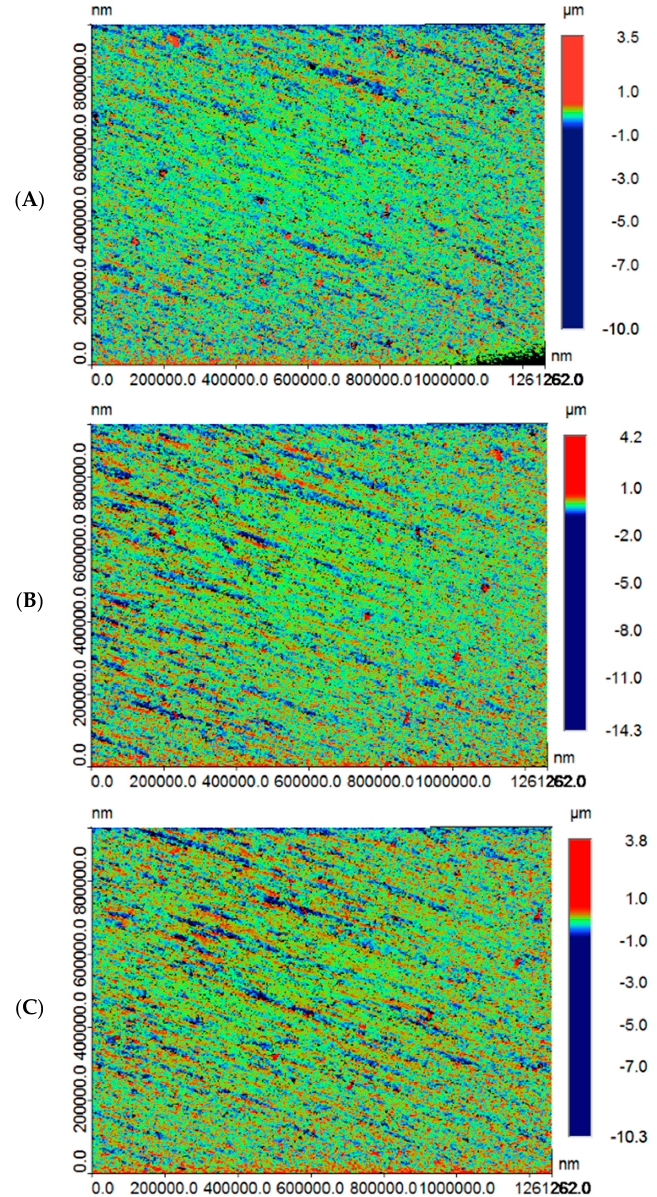
Figure 2. Roughness (Ra) micrographs for study samples in ( A ) CAD-CAM specimen (CC), ( B ) 3D- printed specimen (3D), and ( C ) conventional (CV) specimen groups . For micro-hardness (VHN), the highest and lowest mean was observed in 3D (25.16 ± 4.12 VHN) and CV specimens (21.68 ± 5.53 VHN), respectively. CC specimens showed a mean of 22.07 ± 4.01 VHN (Table 1 and Figure 3). The minimum and maximum VHN